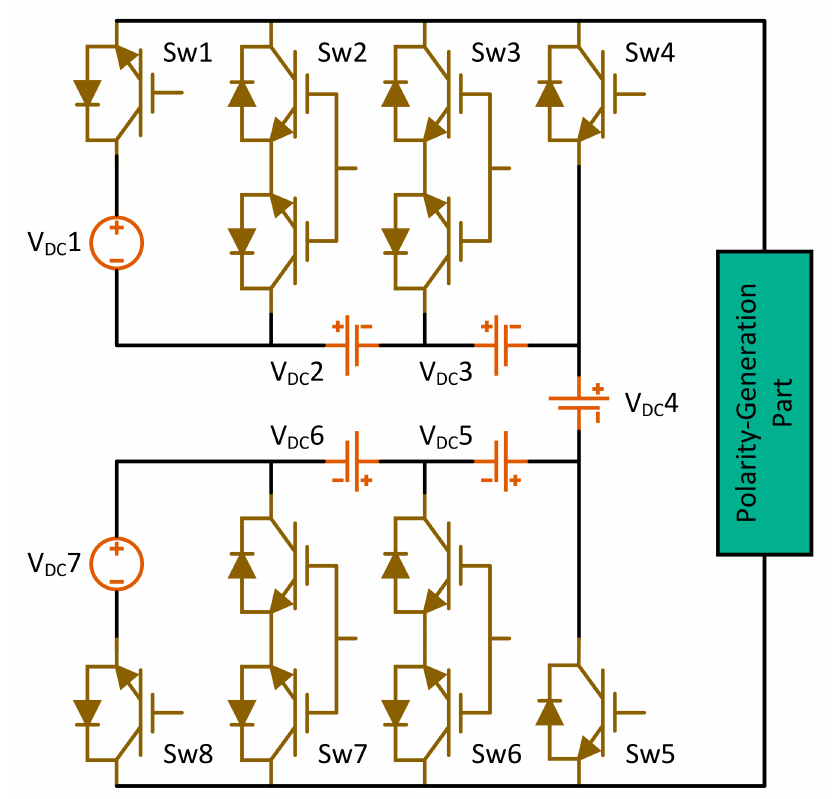
Figure 19. Topology of two switch enabled level generation based multilevel inverter. Topologies without